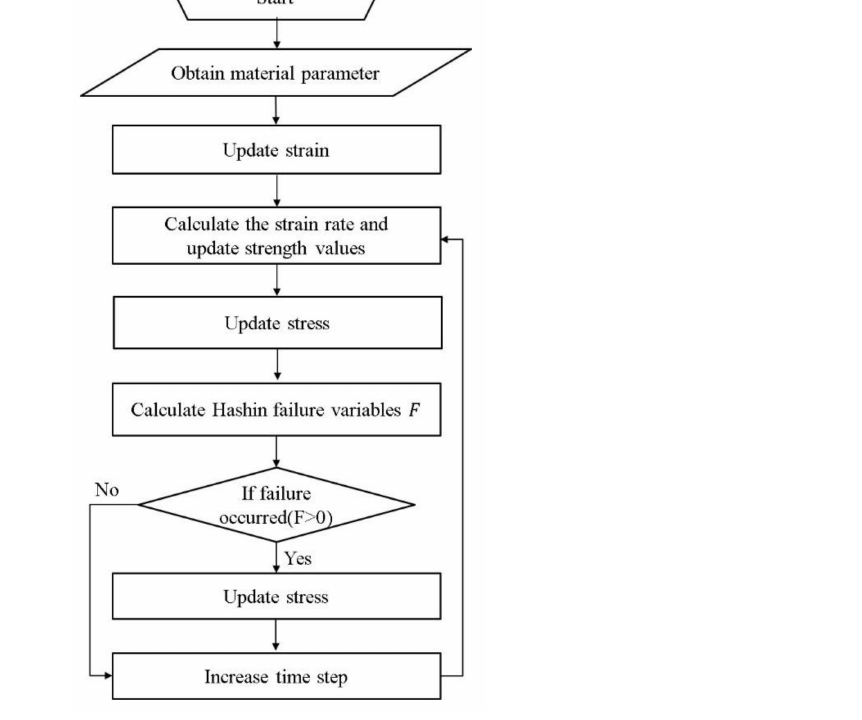
Figure 3. Flowchart of VUMAT for calculating the impact response of the GFRP laminate. Table 3. The mechanical properties of the cohesive